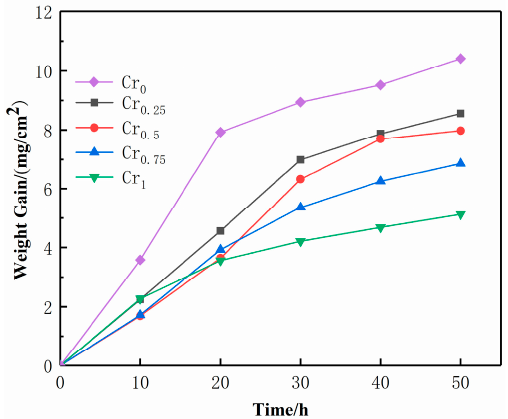
Figure 6. Weight increase of oxide on the surface of WVTaTiCr x RHEA coating. Weight gain (mg/cm 2 ) and weight-gain rate (mg/(cm 2 · h)) of WVTaTiCr x RHEA coating after oxidation at 800 ◦ C for 50 h are shown in Table 3. When Cr is not added, the weight gain and oxidation rate of the WVTaTi high-entropy alloy coating oxide are 10.41 mg/cm 2 and 0.21 mg/(cm 2 · h), respectively. With the increase in Cr content, the weight increases of oxide on the coating surface decreases. The addition of Cr resulted in the smallest increase in oxidation weight of the Cr 1 RHEA coating, with a mass increase of 5.12 mg/cm 2 and an oxidation rate of 0.10 mg/(cm 2 · h). According to the oxidation- resistance rating standard of steel, superalloy, and high-temperature protective coatings (HB5258-2000) [39], it can be seen that Cr 1 RHEA coating belongs to the antioxidant alloys, and Cr 0.25 , Cr 0.5 , and Cr 0.75 belong to the sub-antioxidant alloys. In general, the proper addition of the Cr element can effectively improve the oxidation resistance of the